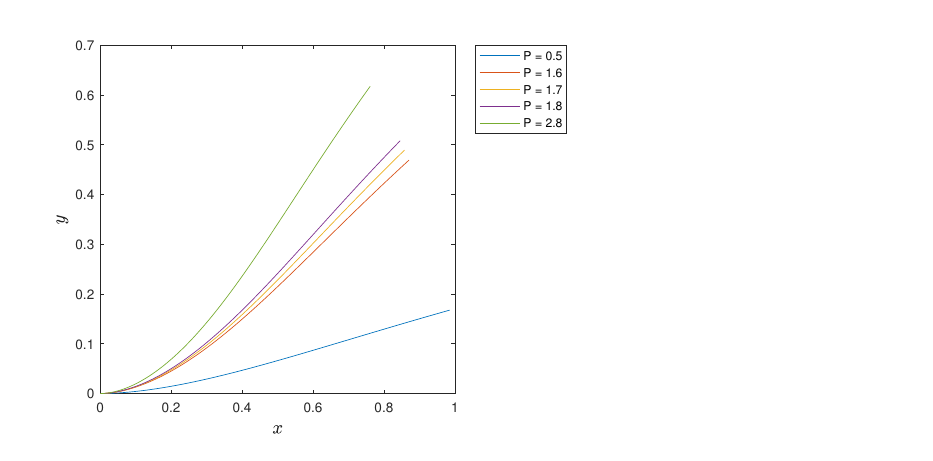
Figure 5. Deflection shapes of a cantilever beam under a uniformly distributed load P = 0.5, 1.6,1.7,1.8, and 2.8 at the equilibrium position when α =